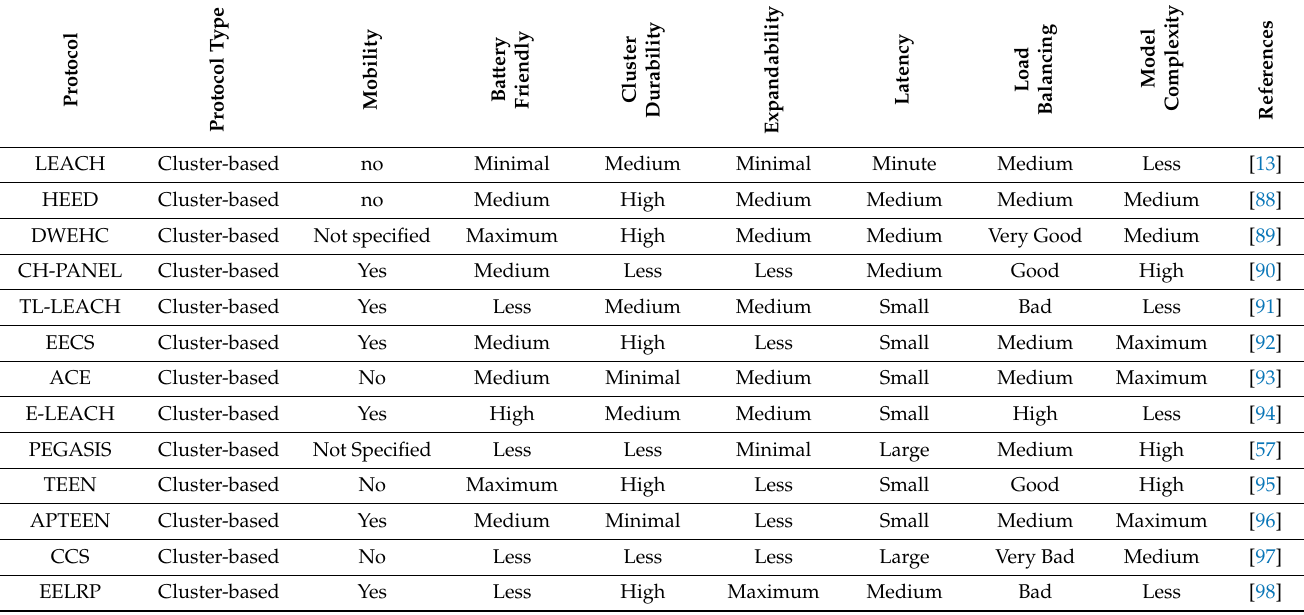
Table 5. Comparative analysis of cluster-based energy-efficient routing